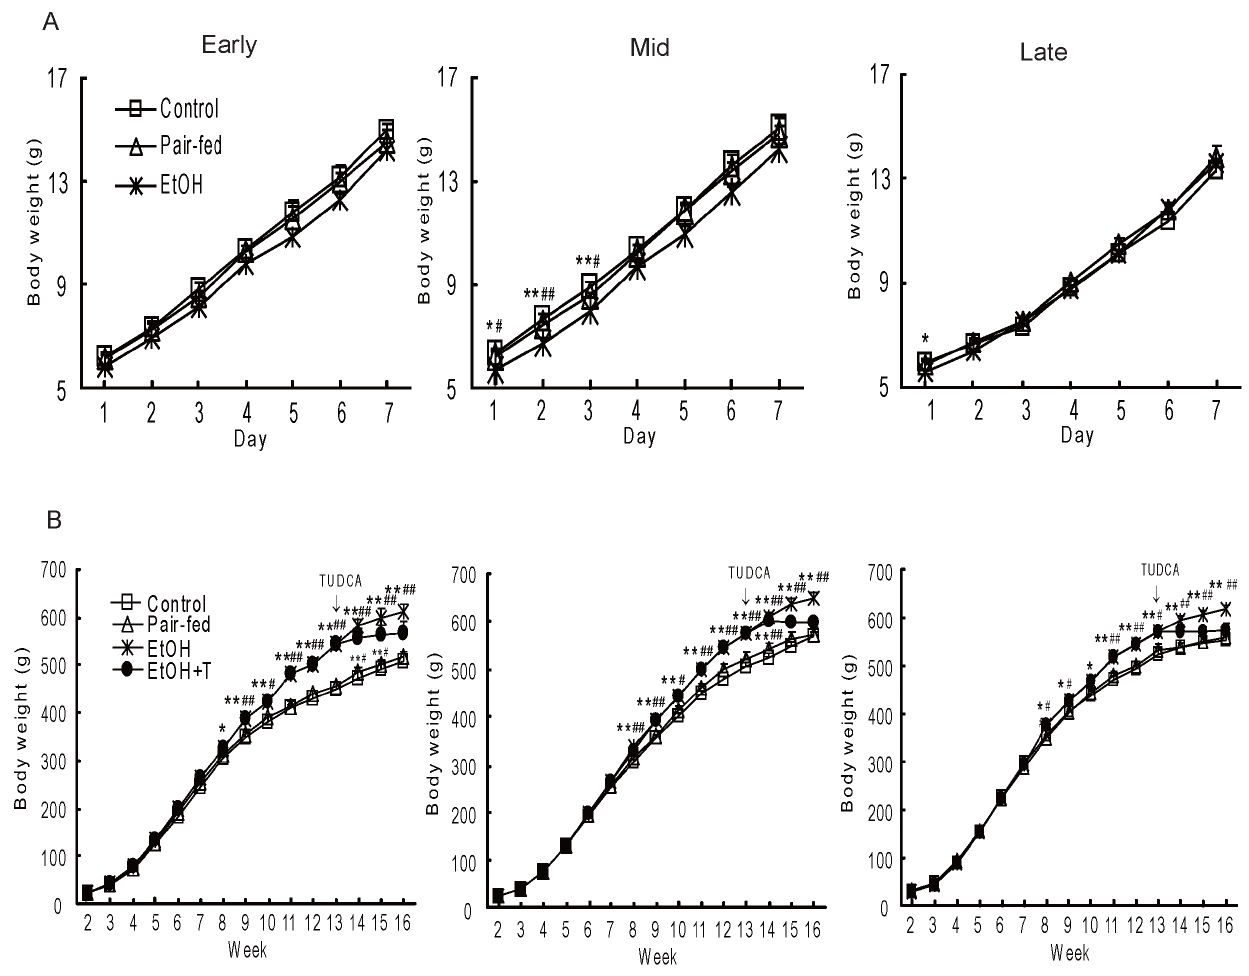
Figure 1. Body weight of male rat offspring during week 1 (A) and weeks 2–16 (B) of life. The offspring were exposed to ethanol (EtOH) or water only during windows of exposure representing early, mid, or late pregnancy. Control and pair-fed offspring were from dams with free access to chow and dams fed the amount of chow consumed by EtOH dams, respectively. TUDCA (T) was given to a subgroup of EtOH offspring for 3 weeks prior to sacrifice. Data shown as the mean 6 SE, n=6. *P , 0.05, **P , 0.01 ethanol (EtOH) vs. control; # P , 0.05, ## P , 0.01 EtOH vs. pair-fed.